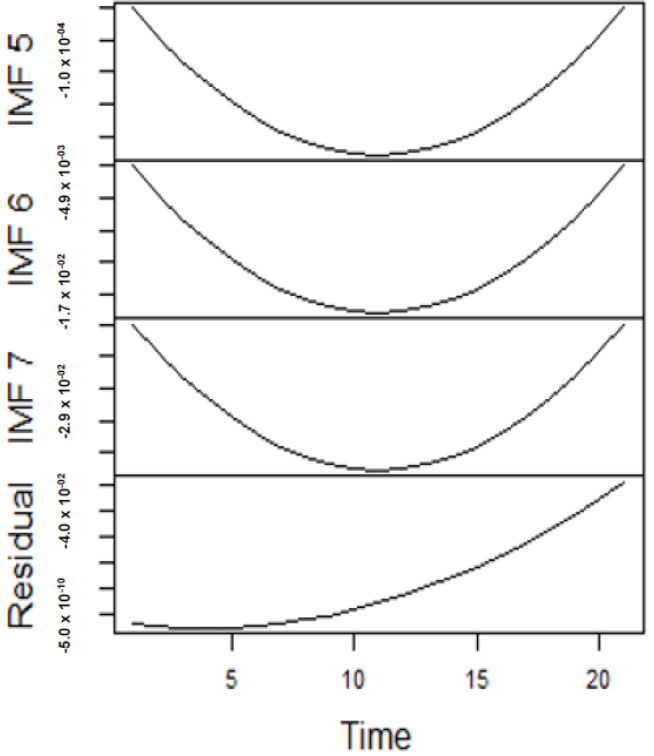
Figure 12. Panel B: The subsequent parts of the IMFs and residuals for Japan gas prices in stress- ful